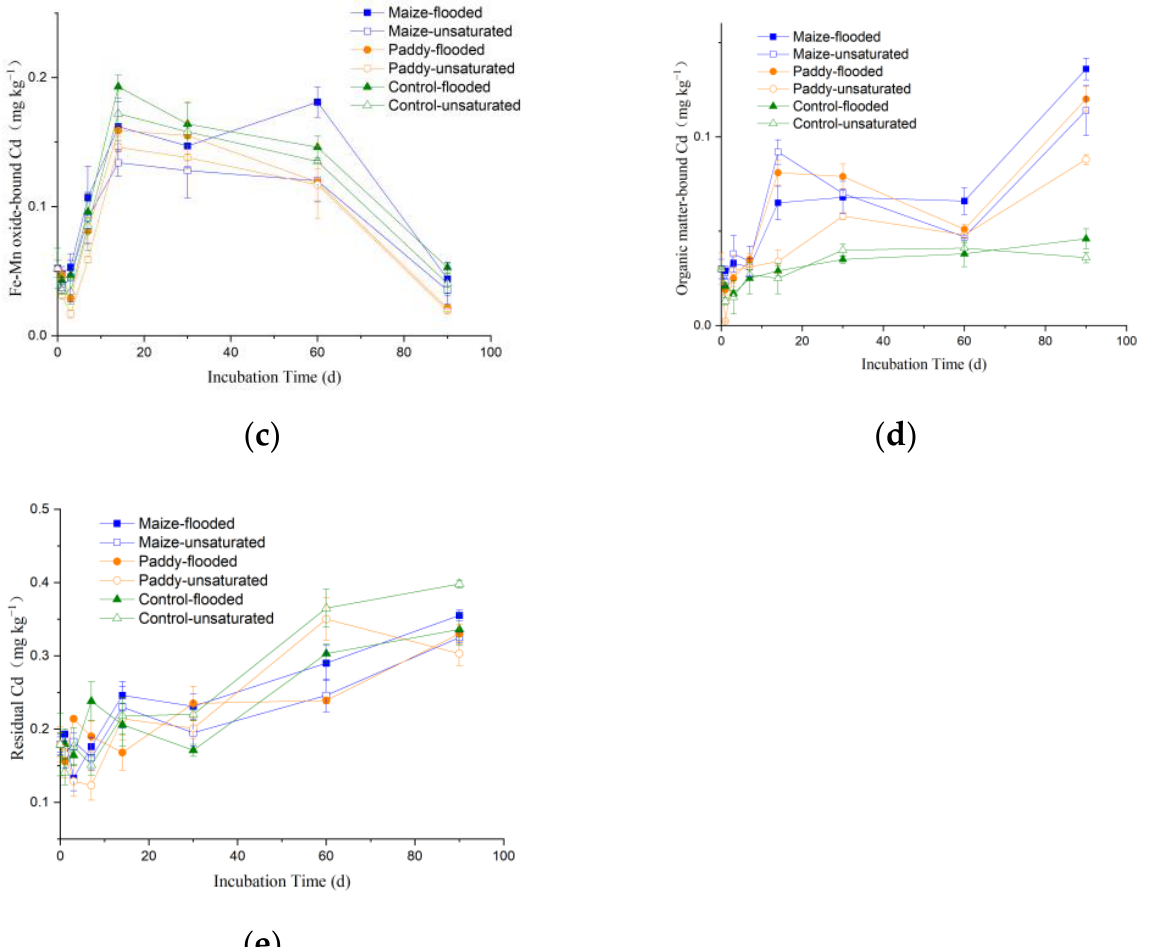
Figure 6. Temporal changes of the content of different Cd fractions (exchangeable Cd ( a ), carbonate-bound Cd ( b ), Fe-Mn oxide-bound Cd ( c ), organic matter-bound Cd ( d ), and residual Cd ( e )) in the soil collected from site B of low pollution level during laboratory incubation under dif- ferent treatments.